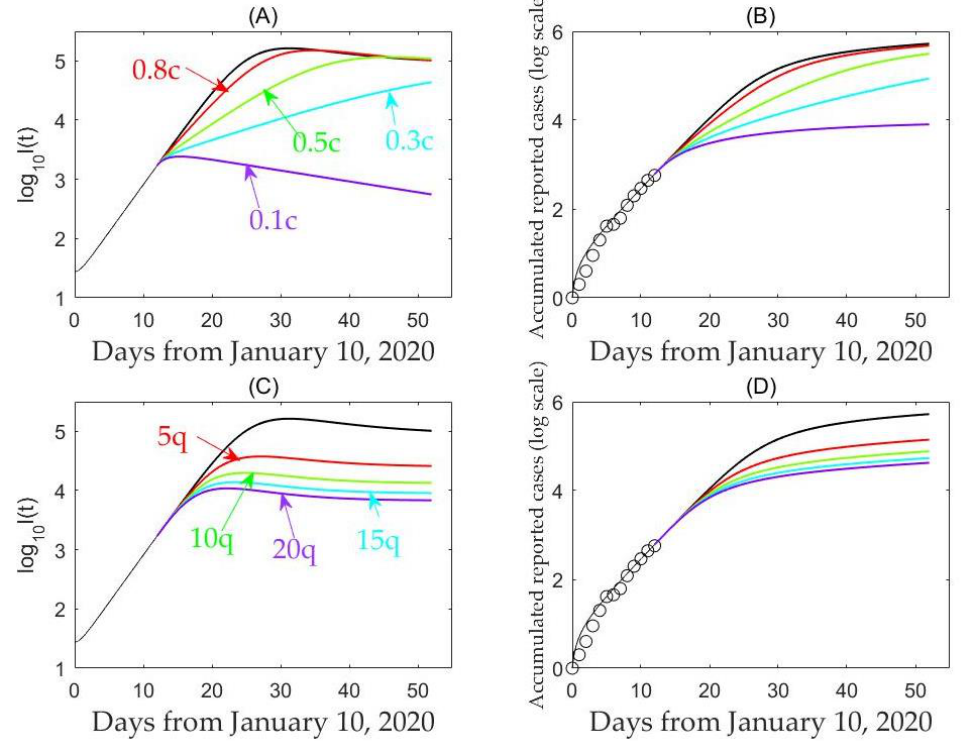
Table 3. The effects of travel restrictions on the peak time and peak value.